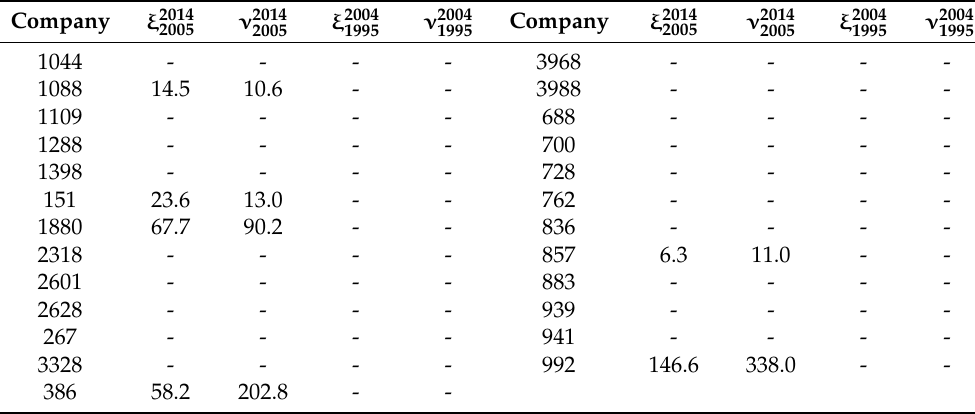
Table A4. Estimated parameters ξ ( % ) and ν ( % ) , for each company of HSFML25 index.